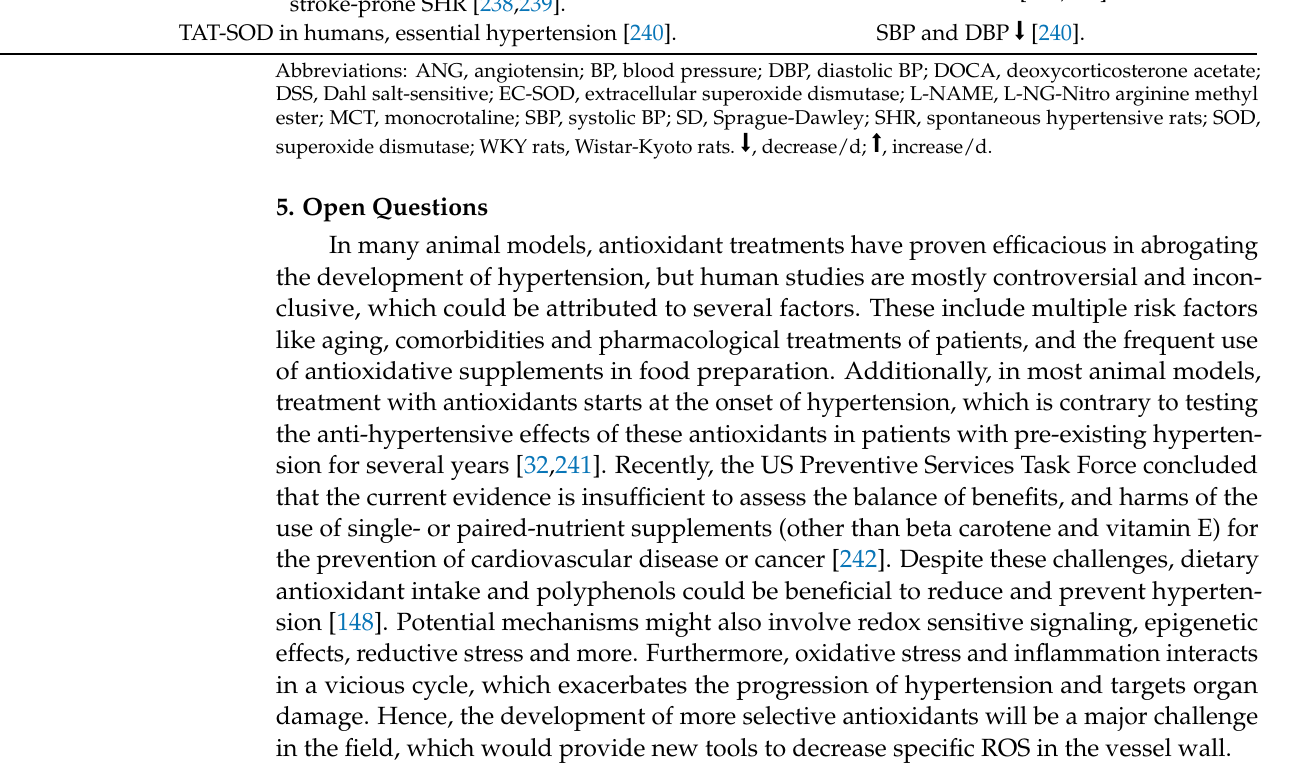
Table 1. Studies analyzing the impact of antioxidants on hypertension in animal and human studies.